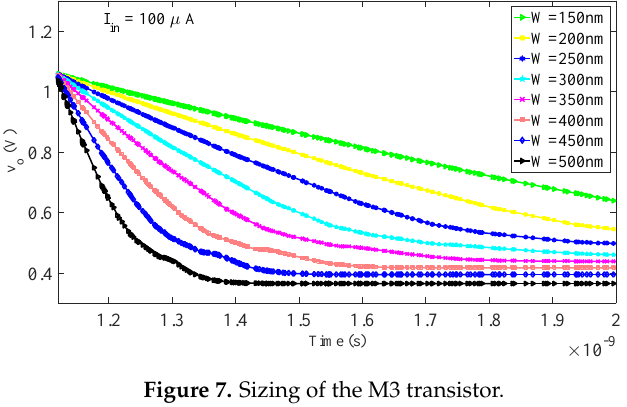
Figure 7. Sizing of the M3 transistor.